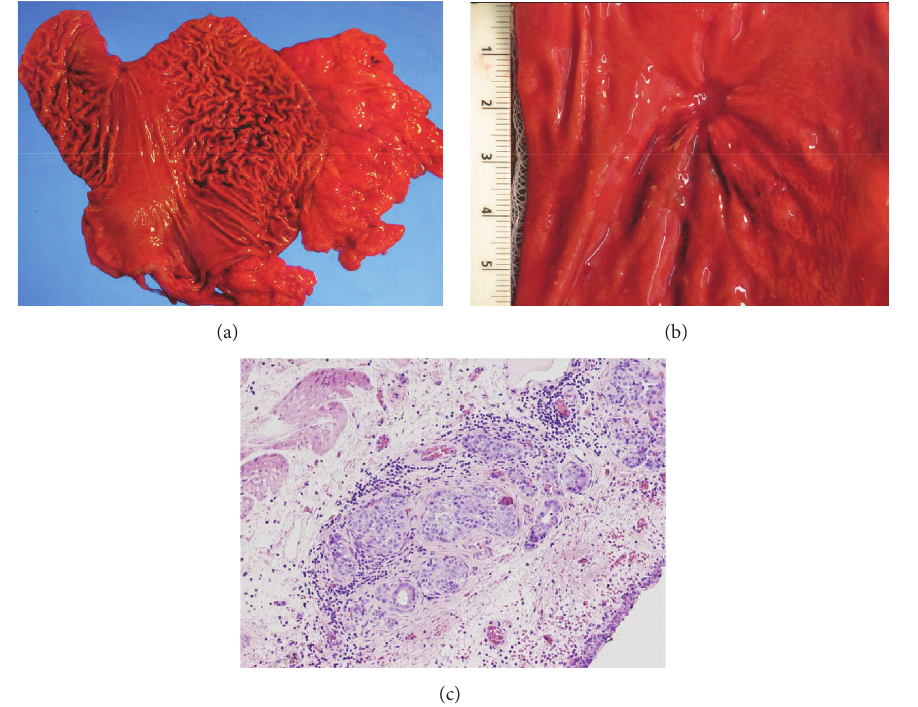
Figure 1: Resected stomach (a) containing prior polypectomy site with mucosal irregularity (b). (c) Small focus of residual neuroendocrine tumor involving the subserosa (H&E,